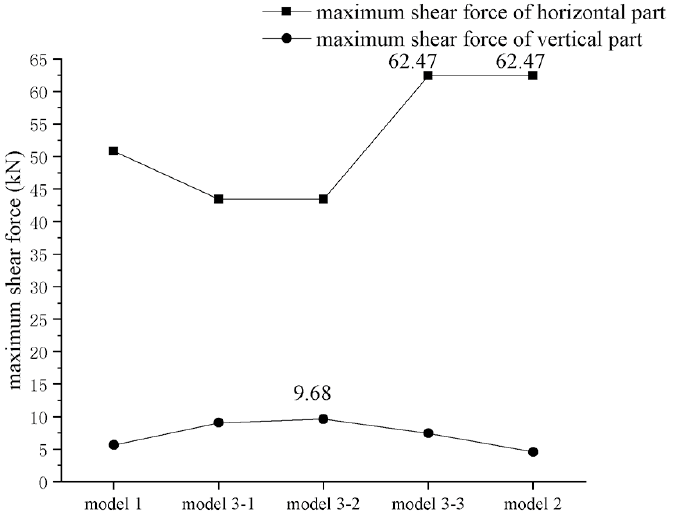
Figure 21. Maximum shear forces of the horizontal part and vertical part for the L-shaped components in each model.